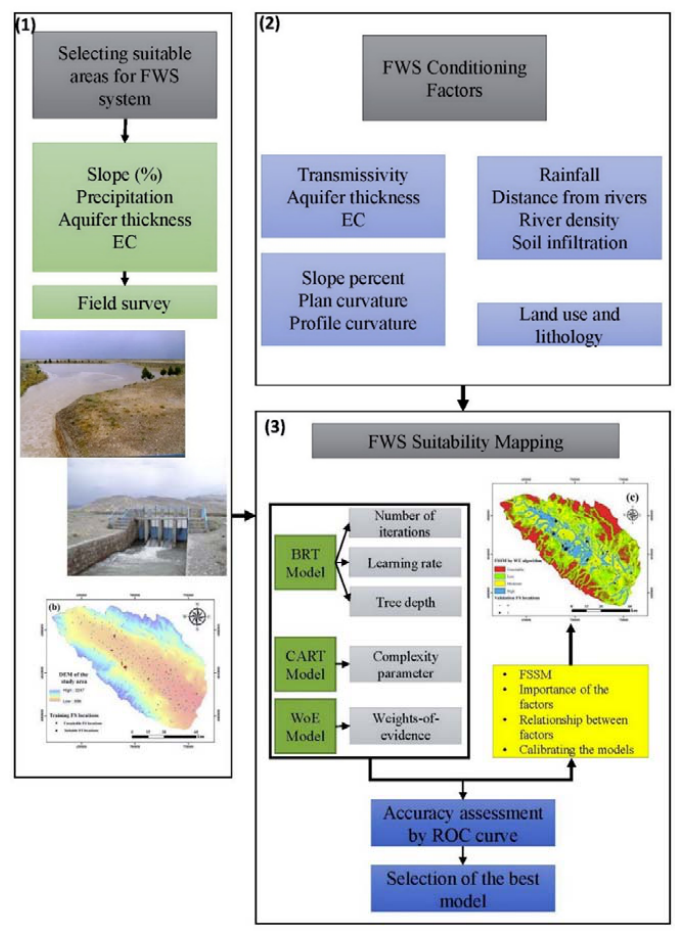
Figure 1. The methodology used to detect the FWS suitable and unsuitable locations, as well as preparing the FWS conditioning factors and modeling procedure, in this research.